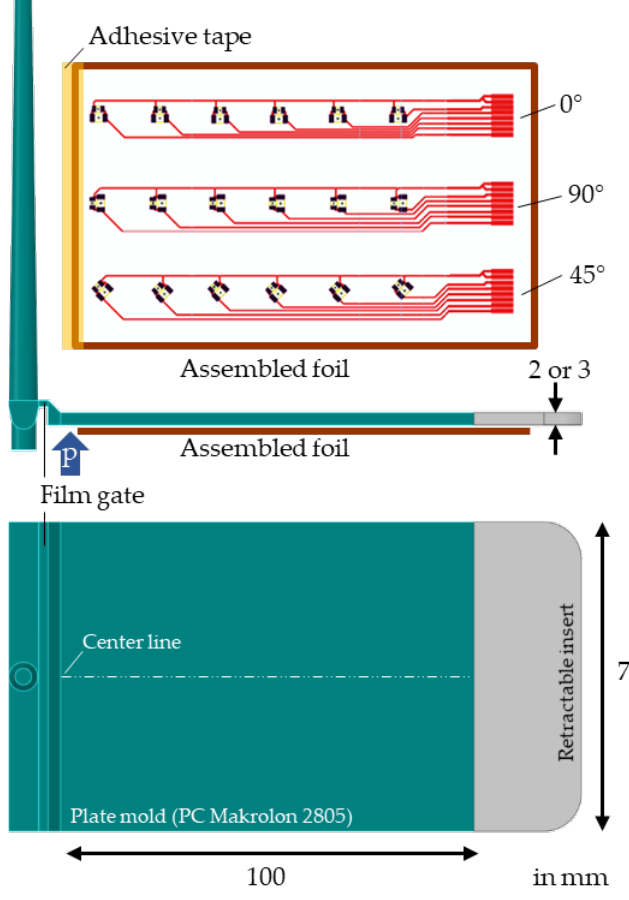
Figure 3. Setup of the plate mold with dimensions, where the foils were placed on the bottom side for overmolding. The insert, drawn in grey, was used to keep the foil contacts free from overmolding. As the blue arrow indicates, the mold was equipped with a pressure sensor close to the gate.